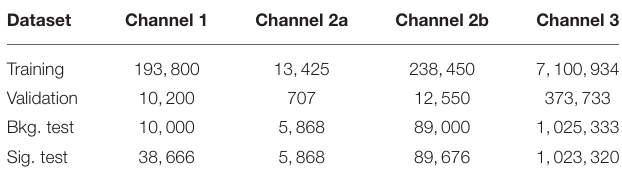
TABLE 1 | Summary of the available dataset